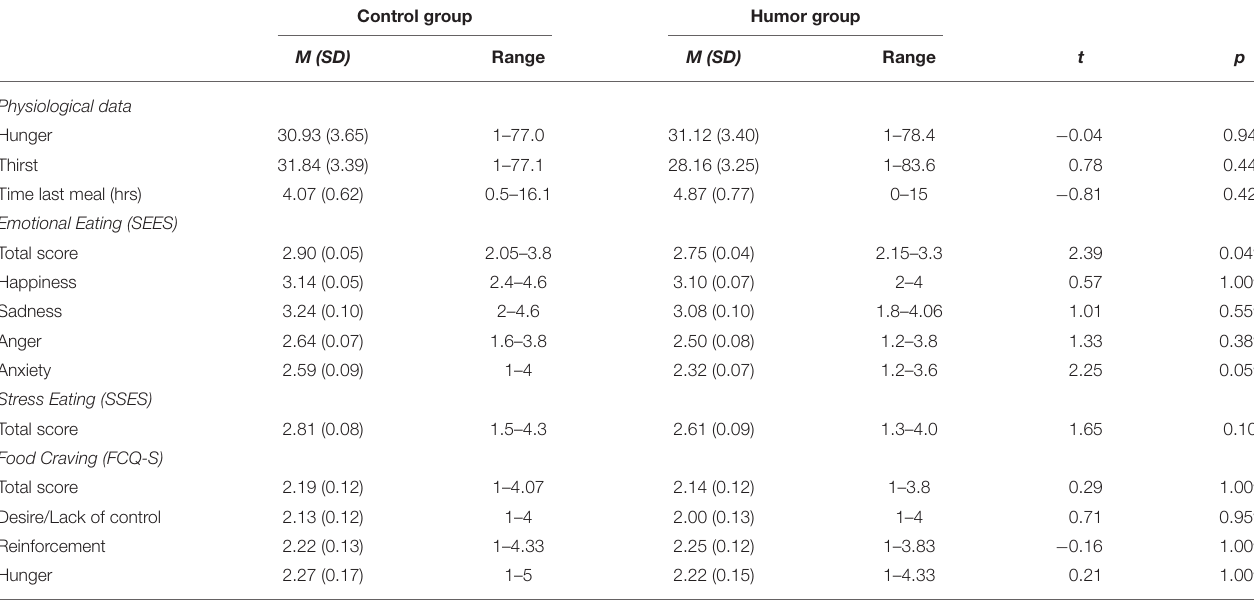
TABLE 1 | Group characteristics with respect to homeostatic state and eating behavior.